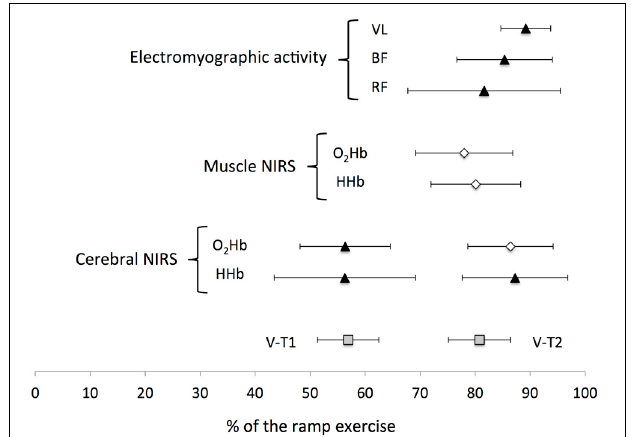
FIGURE 2 | Mean ( ± SD) location of the non-linear changes occurring during a ramp exercise. V-T1 and V-T2, first and second ventilatory thresholds. NIRS, Near-infrared spectroscopy; VL, vastus lateralis ; BF, biceps femoris ; RF, rectus femoris ; HHb, deoxyhemoglobin; O 2 Hb,